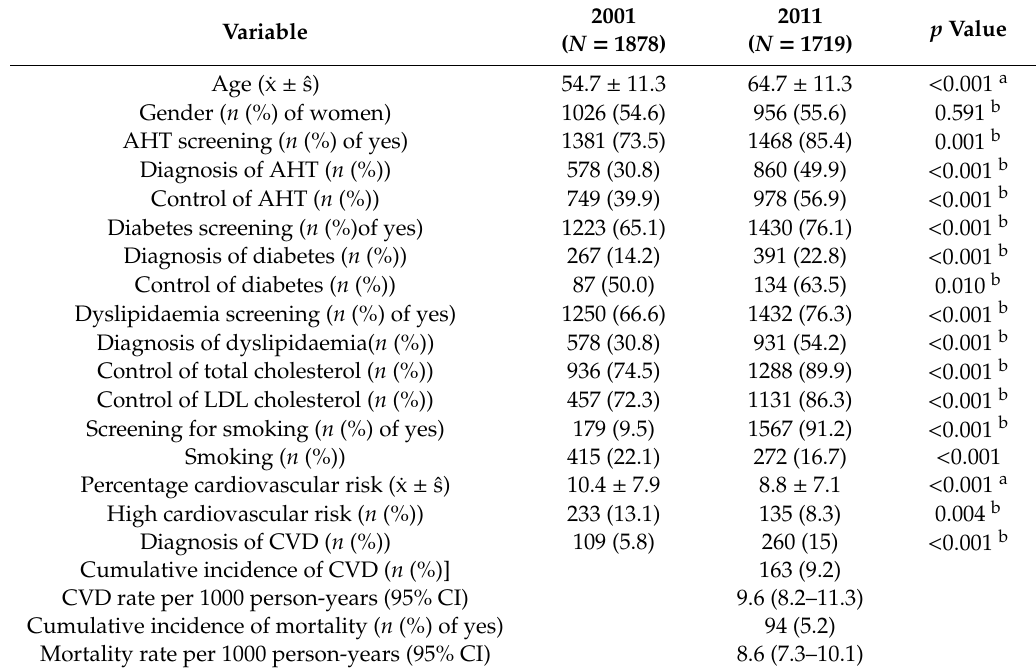
Table 2. Sociodemographic characteristics and indicators of health, cardiovascular disease and mortality at baseline and at of the 10-year